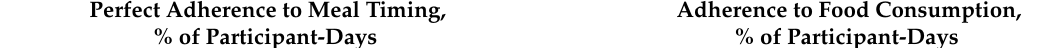
Table 5. Distribution of perfect adherence to meal timing and adherence to food consumption by study week over the 12-week feeding